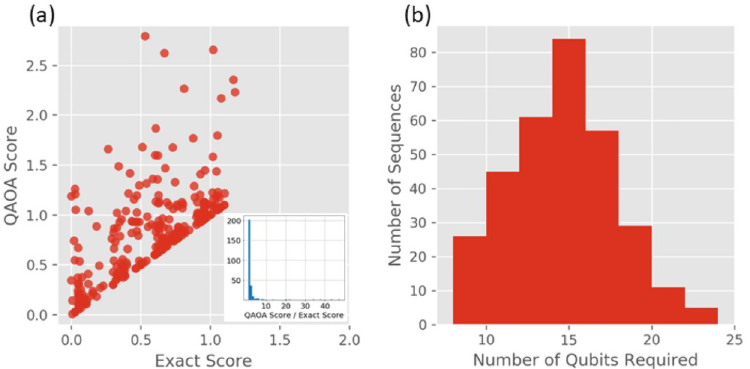
Fig 4. (a) QAOA simulated scores vs exact scores. Each point represents a single run of the simulator for each peptide fragment. Lower scores indicate higher quality results. Trials that returned solutions with invalid mapping between codons and amino acids were excluded. Inset shows a histogram of the QAOA score to exact score ratios where it can be seen that the majority of the ratios are close to 1. (b) Number of qubits required to simulate each of the 313 peptide fragments of length